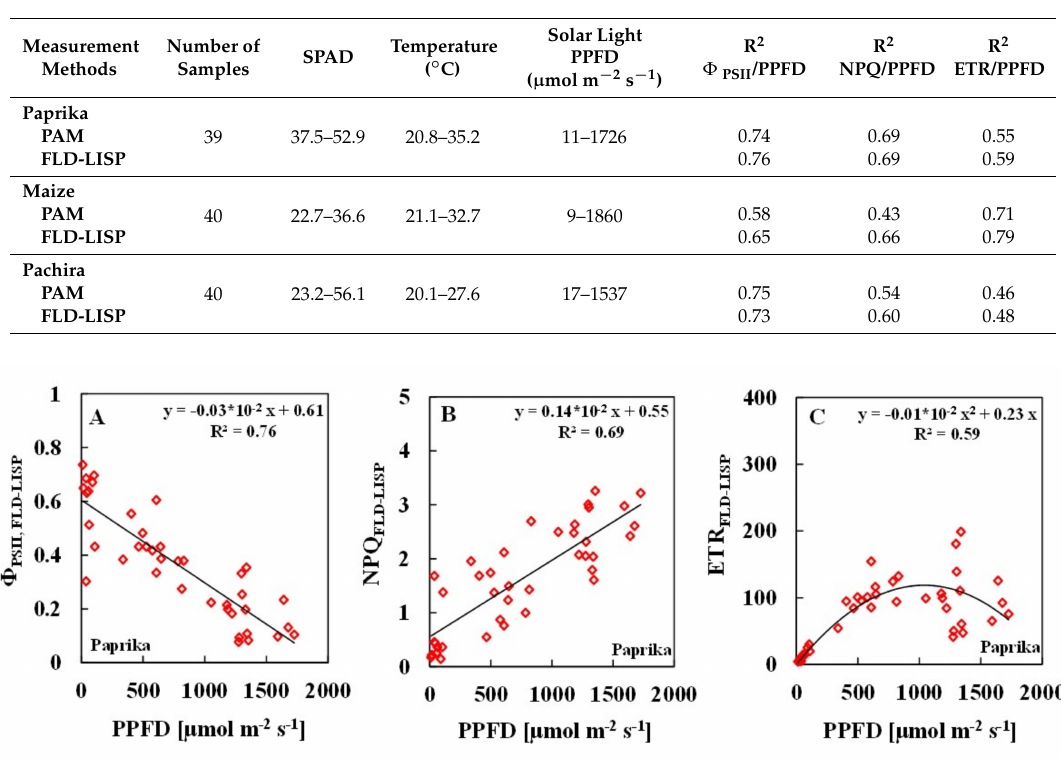
Table 1. Experimental conditions of the three plant species and the coefficients of determination (R 2 ) between ChlF parameters ( Φ PSII , photochemical yield of photosystem II; NPQ, non-photochemical quenching; and ETR, photosystem II-based electron transport rate) and solar PPFD using the PAM and FLD-LISP methods.